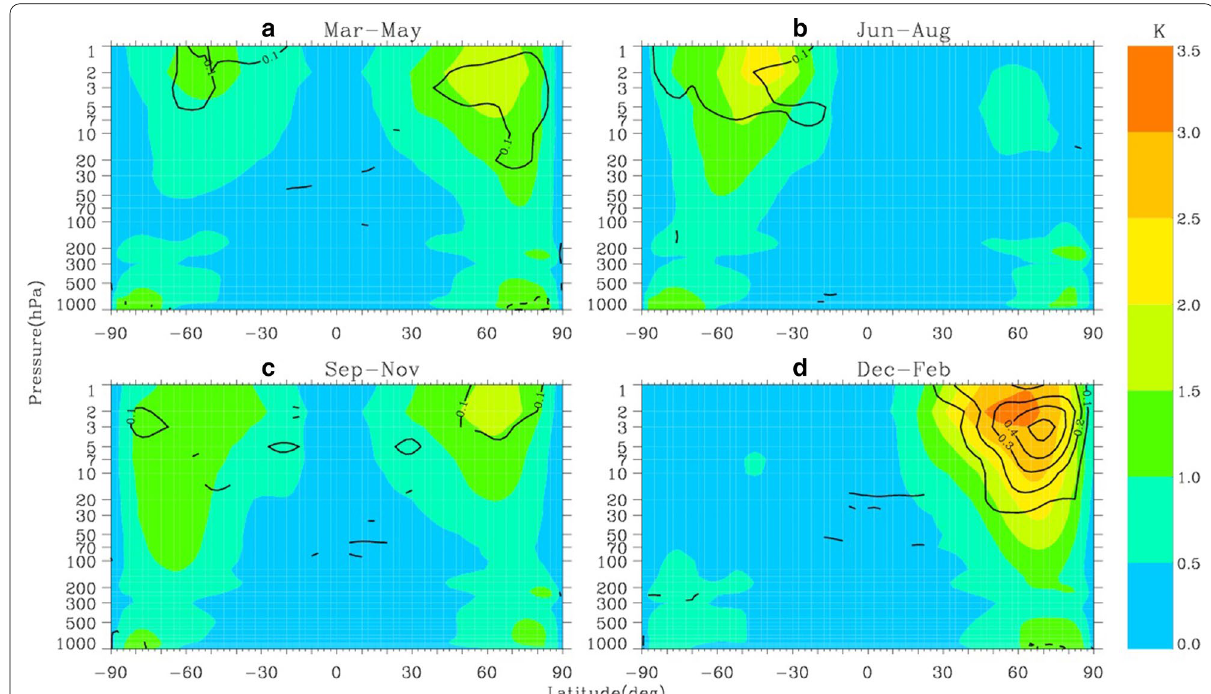
Fig. 8 Contours represent the seasonal variation of the long-term trend (in K per decade) of the monthly-mean Q16W1 temperature amplitude from the 39 year ERA-Interim temperature data set. The solid and dashed contours denote the positive and negative trends, respectively. Only the trends with a confidence level at/above 95% are plotted. The colors represent the climatological mean of seasonal Q16W1 temperature